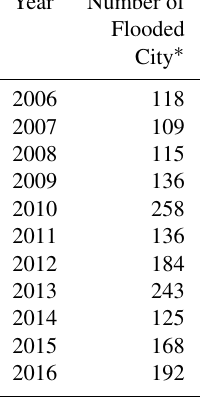
Table 1. Data of Flooded Cities from 2006 to 2016 in China (MWR,